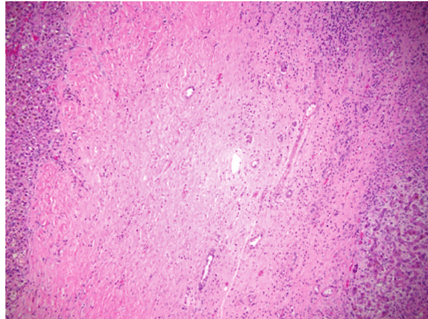
Figure 5: Liver explants histopathology showing fibrosis with embedded bile ductules, regenerating hepatocytes, and fibroblasts indicative of prior radiation therapy.